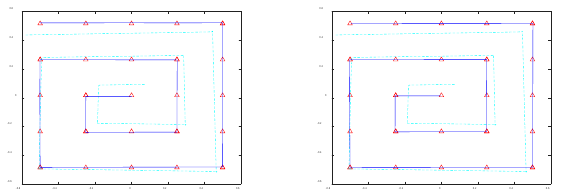
Figure 1: Estimated trajectory using GP-SLAM with different true σ f . (Top Left) σ f = 0.001, (Top Right) σ f = 0.100, (Bottom Left) σ f = 1.000, and (Bottom Right) σ f = 10.00. The cyan dash line shows the odometry only solution, the blue solid line indicates the GP-SLAM solution, and the red triangles are the ground truth.